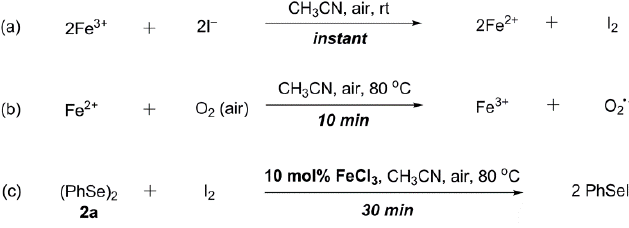
Scheme 2. Separated control redox reactions without o -vinylanilide.